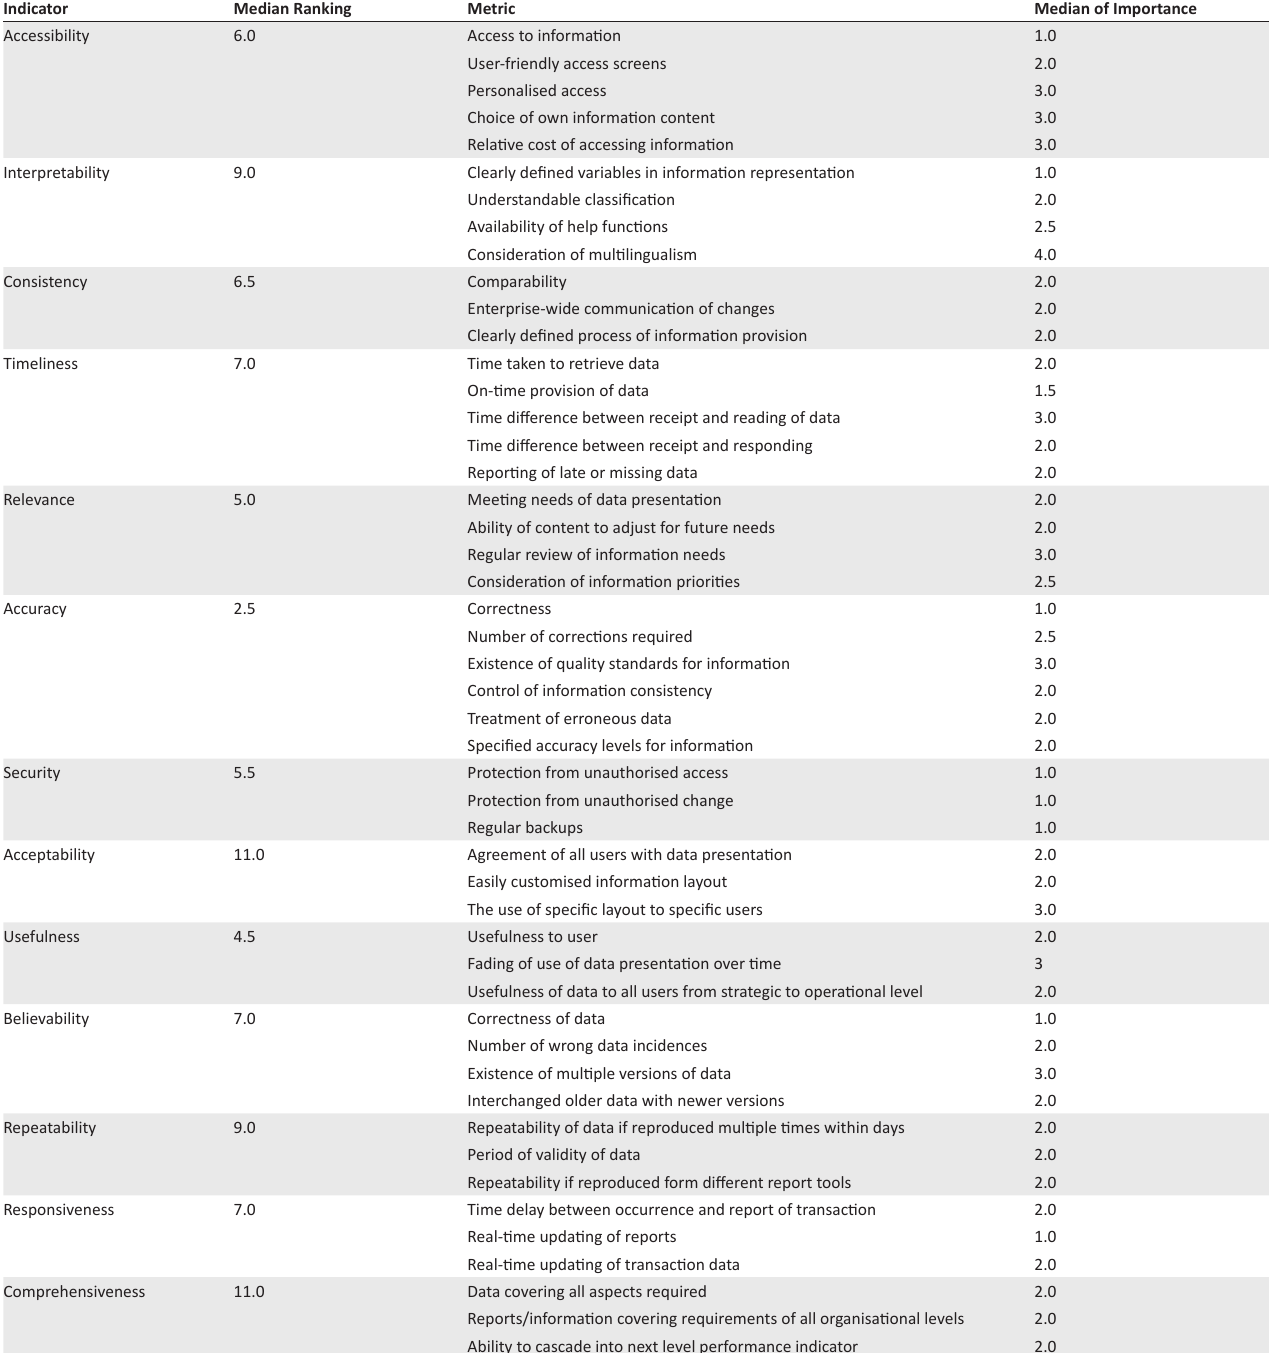
TABLE 2: Median Importance rankings and ratings indicators and associated